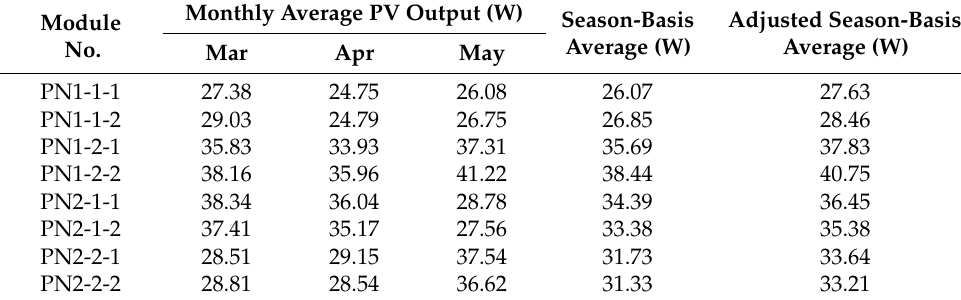
Table 3. Output characteristics of new PV modules in spring.